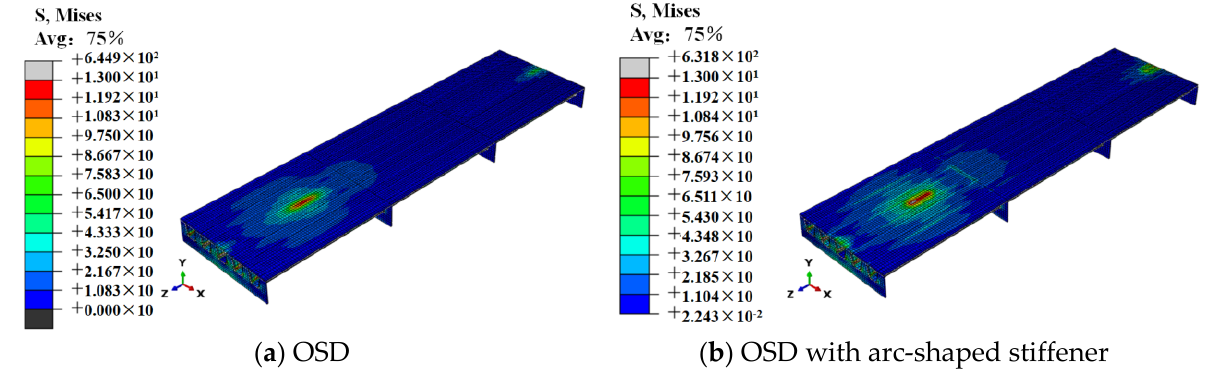
Figure 8. The stress state of the steel bridge deck (MPa).